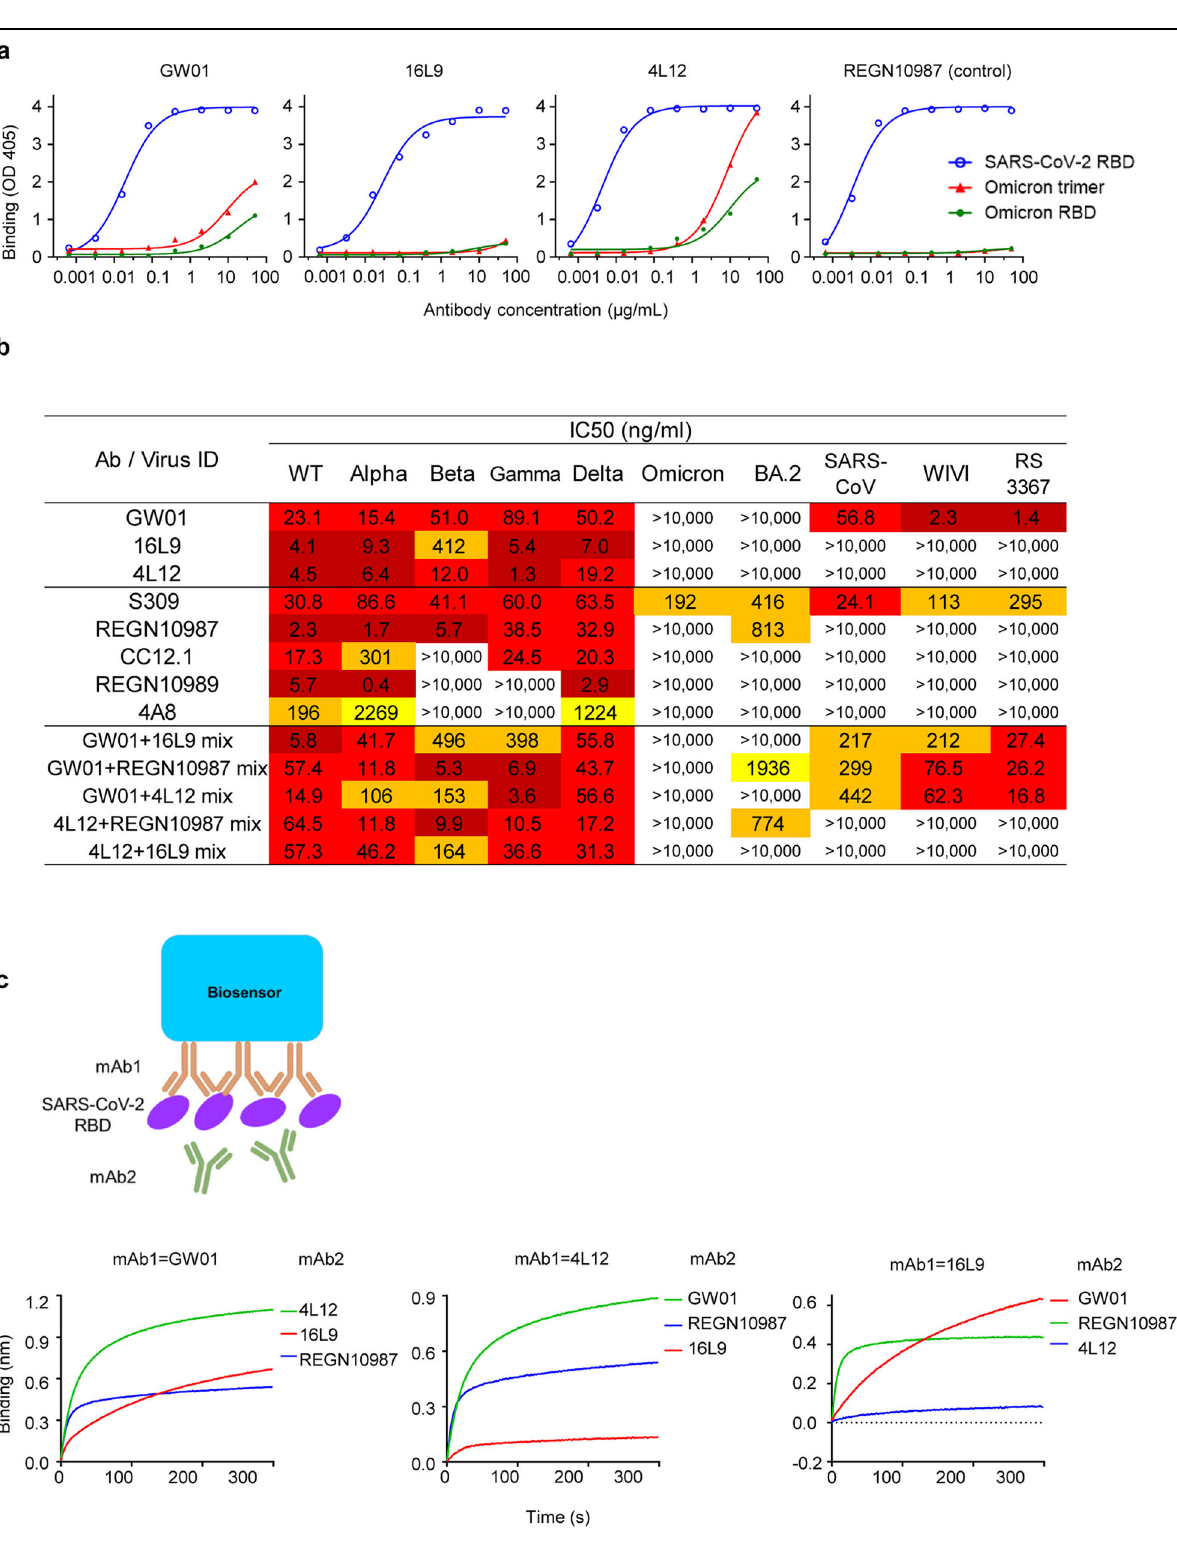
Fig. 1 Isolation of three non-Omicron NAbs from COVID-19 convalescent individuals. a Binding of GW01, 16L9, and 4L12 to the SARS-CoV-2 RBD, Omicron RBD and trimer in an ELISA. REGN10987 was used as a control. b Neutralizing activities of GW01, 16L9, and 4L12 and their combinations against pseudotyped SARS-CoV-2 and its variants Alpha, Beta, Gamma, Delta, and Omicron, as well as sarbecoviruses. S309 was used as a positive control. c Binding of 4L12, 16L9, and RGN10987 to the SARS-CoV-2 RBD in competition with GW01, as measured by